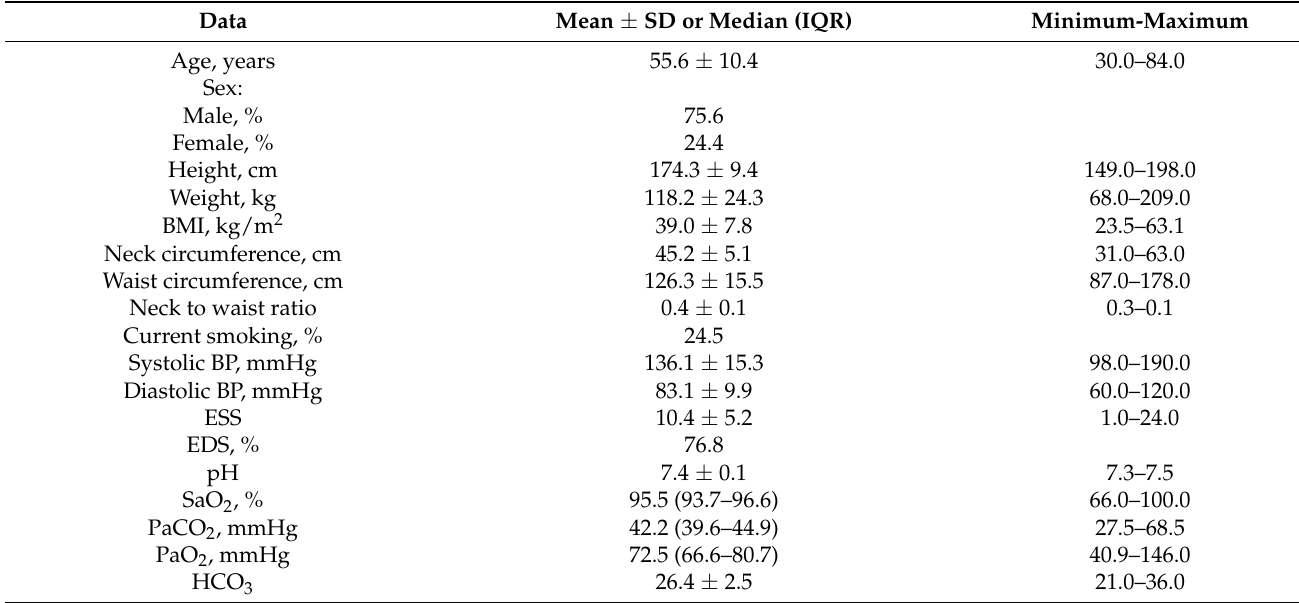
Table 1. Characteristics of the study population.